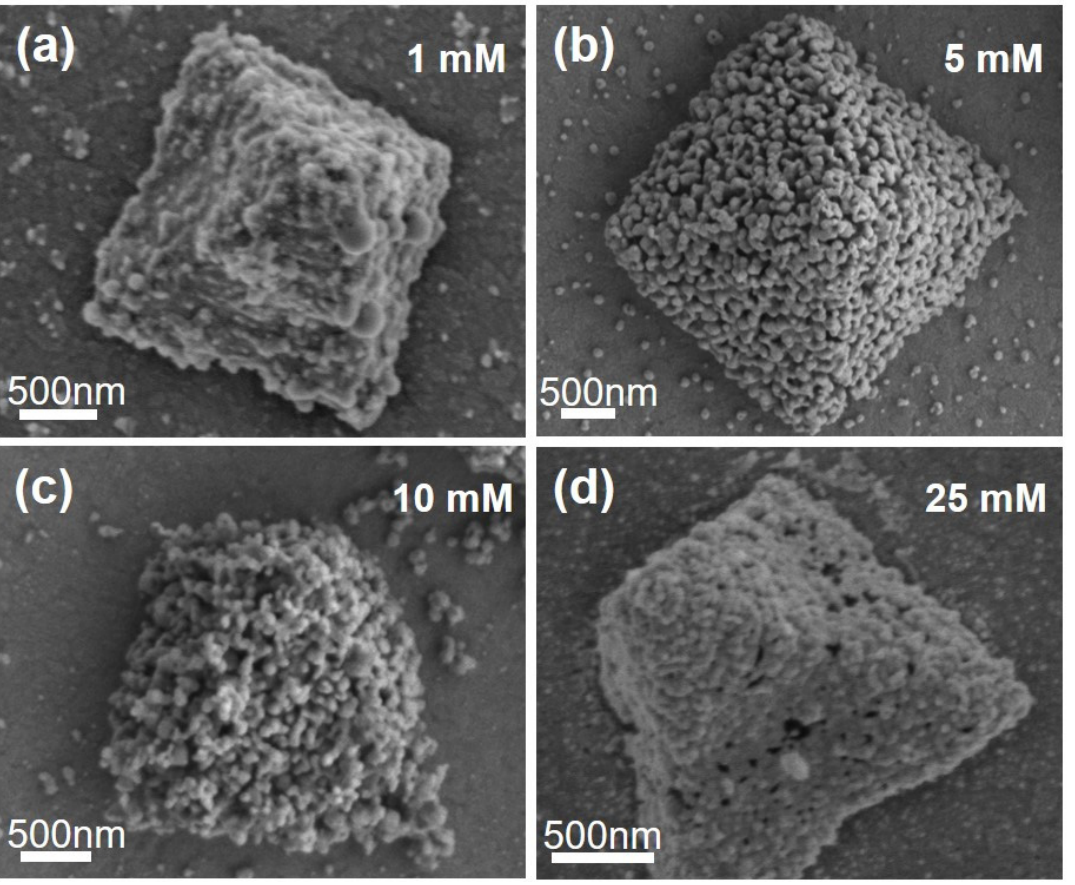
Figure 2. SEM images of the nanoporous Ag-decorated Ag 7 O 8 NO 3 micro-pyramids fabricated by using NaBH 4 solution with different concentrations: ( a ) 1 mM; ( b ) 5 mM; ( c ) 10 mM; and ( d ) 25